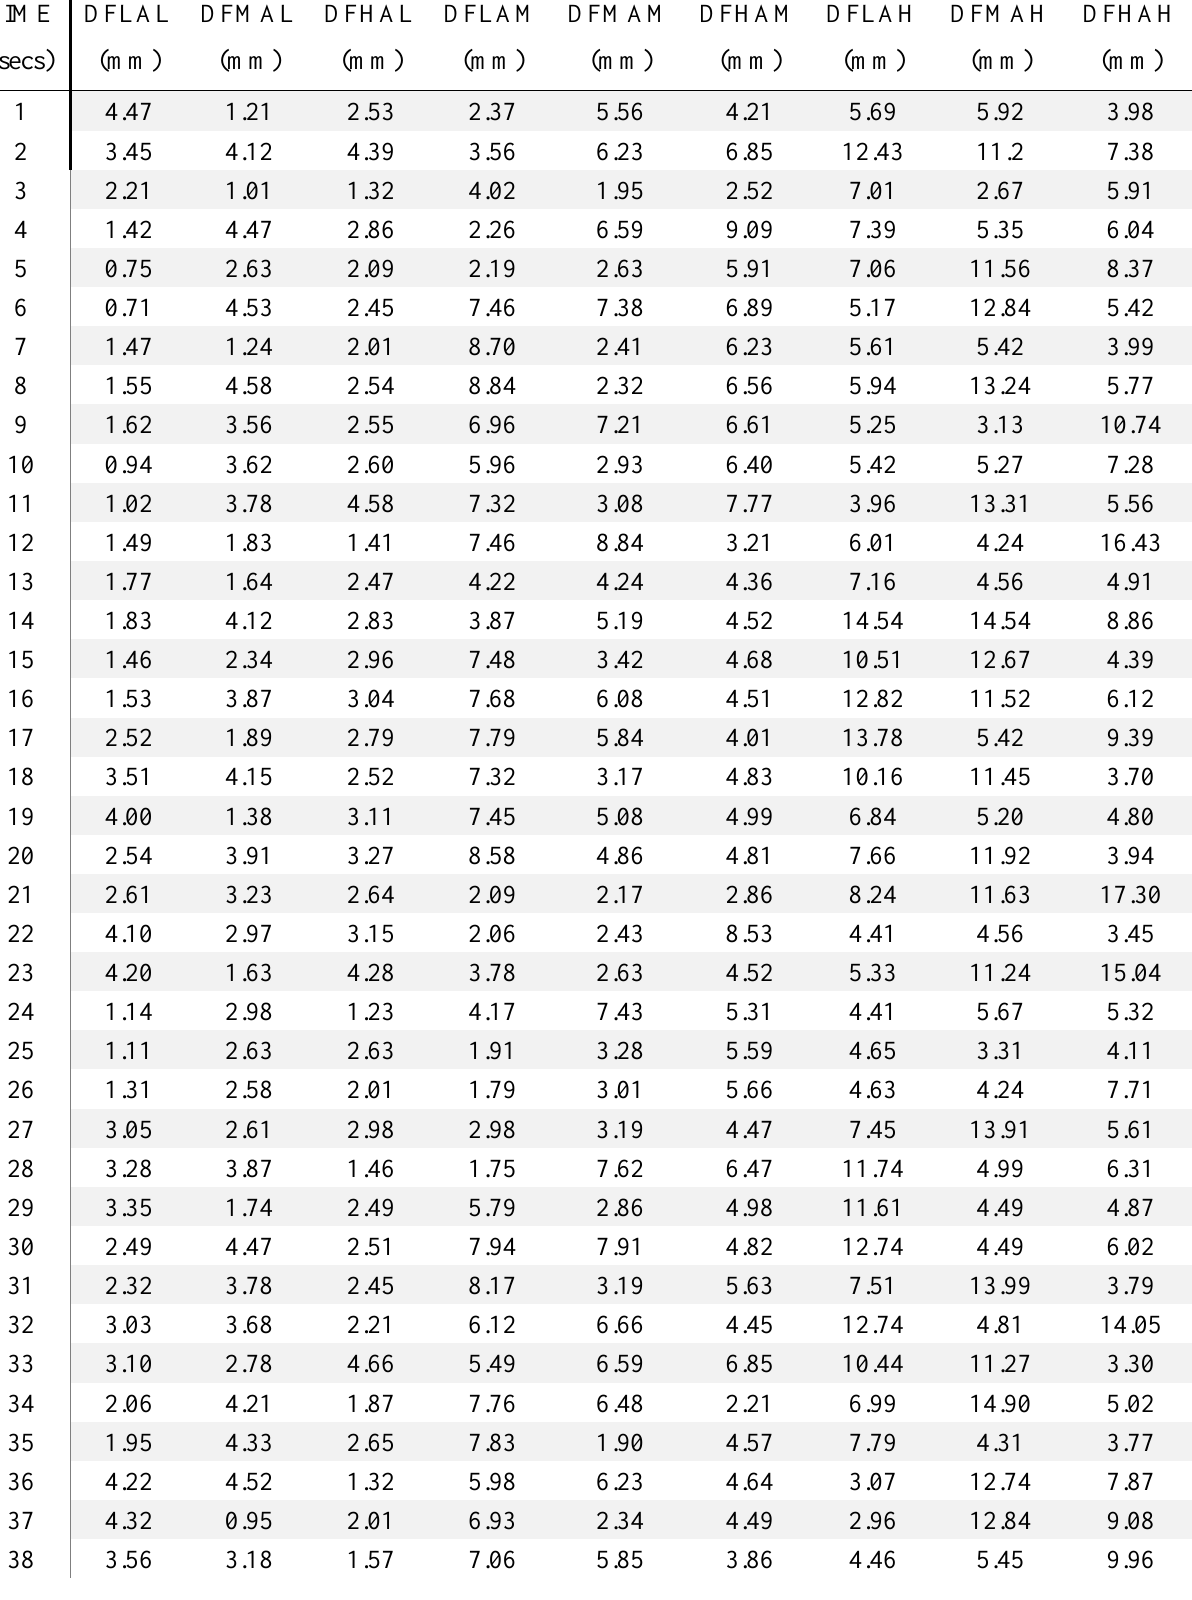
Table 8. The displacement – time of the vibration of the mechanical yam vibrator at different levels of frequency and amplitude (Days of record: 13/01/2020 and